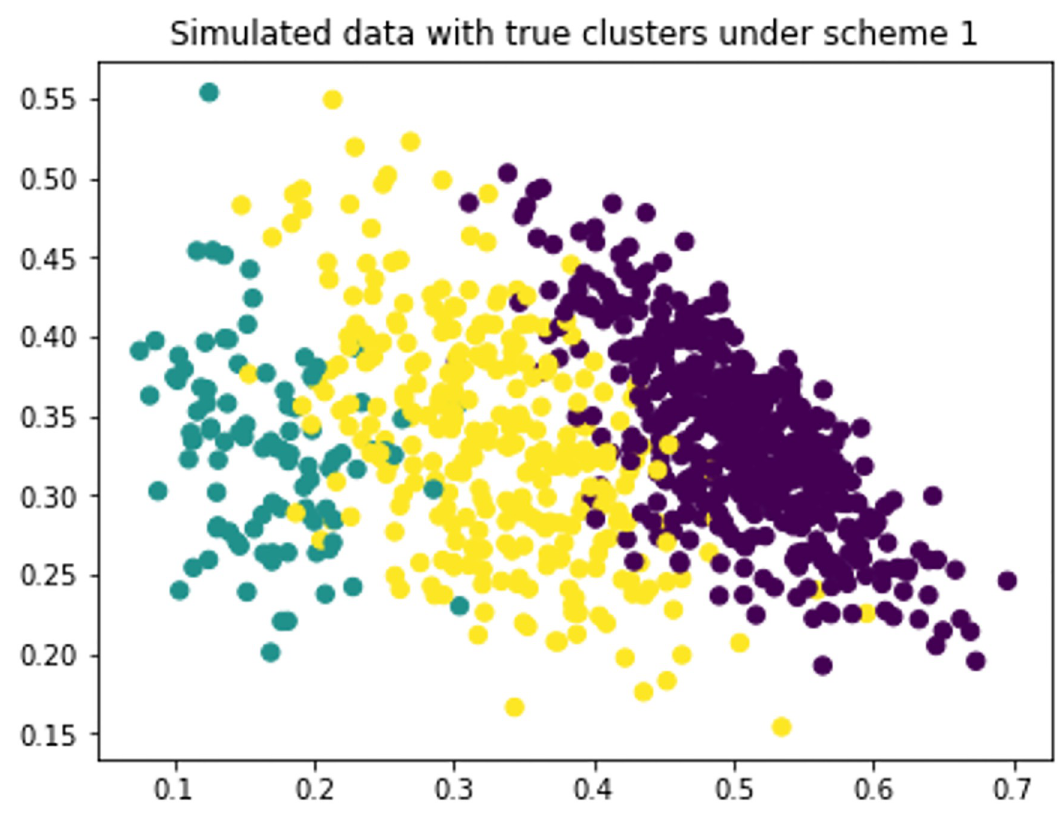
Fig 1. Simulated data generated under scheme 1 with true